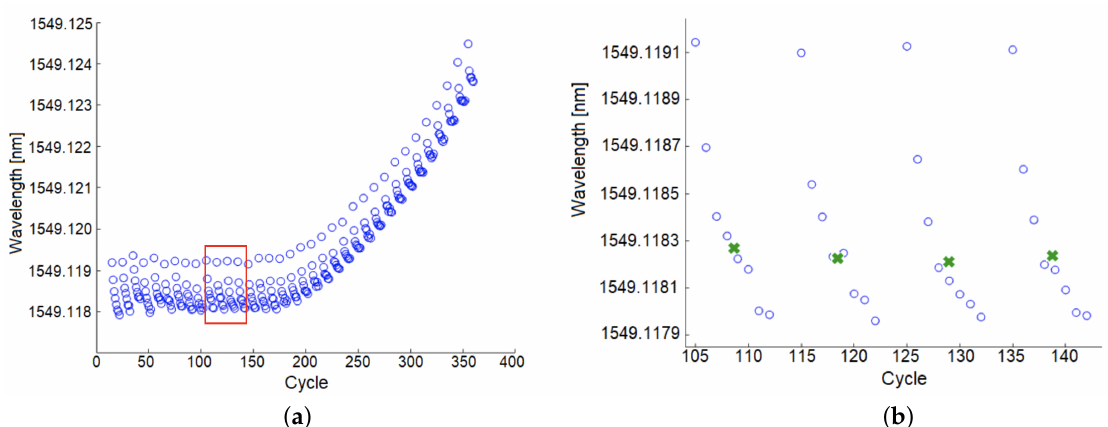
Figure 9. ( a ) Peaks of the FBG strain signal during the pre-cracking phase. The DIC was triggered with a low peak (not shown) every eight cycles. ( b ) Detailed view extracted from the red box. The green x markers indicate the mean of each set.